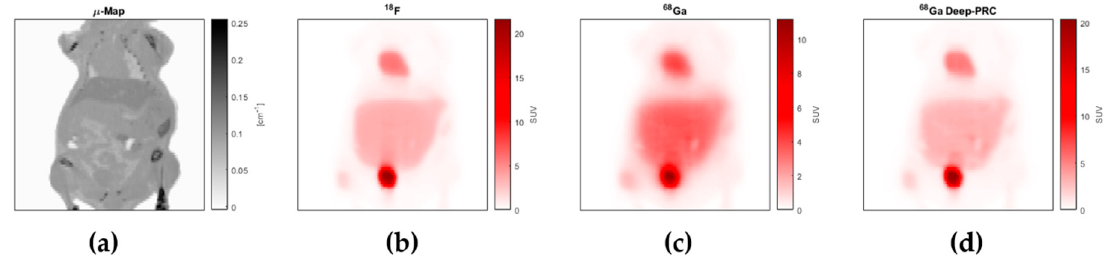
Figure 6. Example of a coronal view of one of the evaluated cases, corresponding to the µ -map obtained from the CT ( a ), and the reconstructed images of 18 F ( b ), 68 Ga ( c ), and 68 Ga after the PRC ( d ).